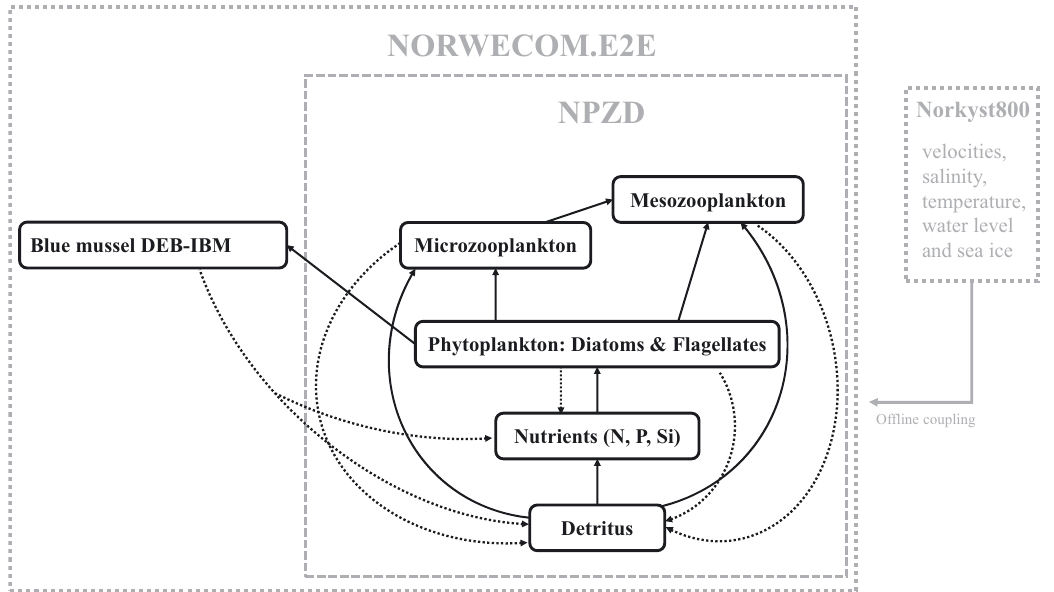
Fig. 2. Conceptual scheme of the NORWECOM.E2E model. Solid lines represent uptake via grazing, while dotted lines represent loss terms linked to grazing, such as egestion and